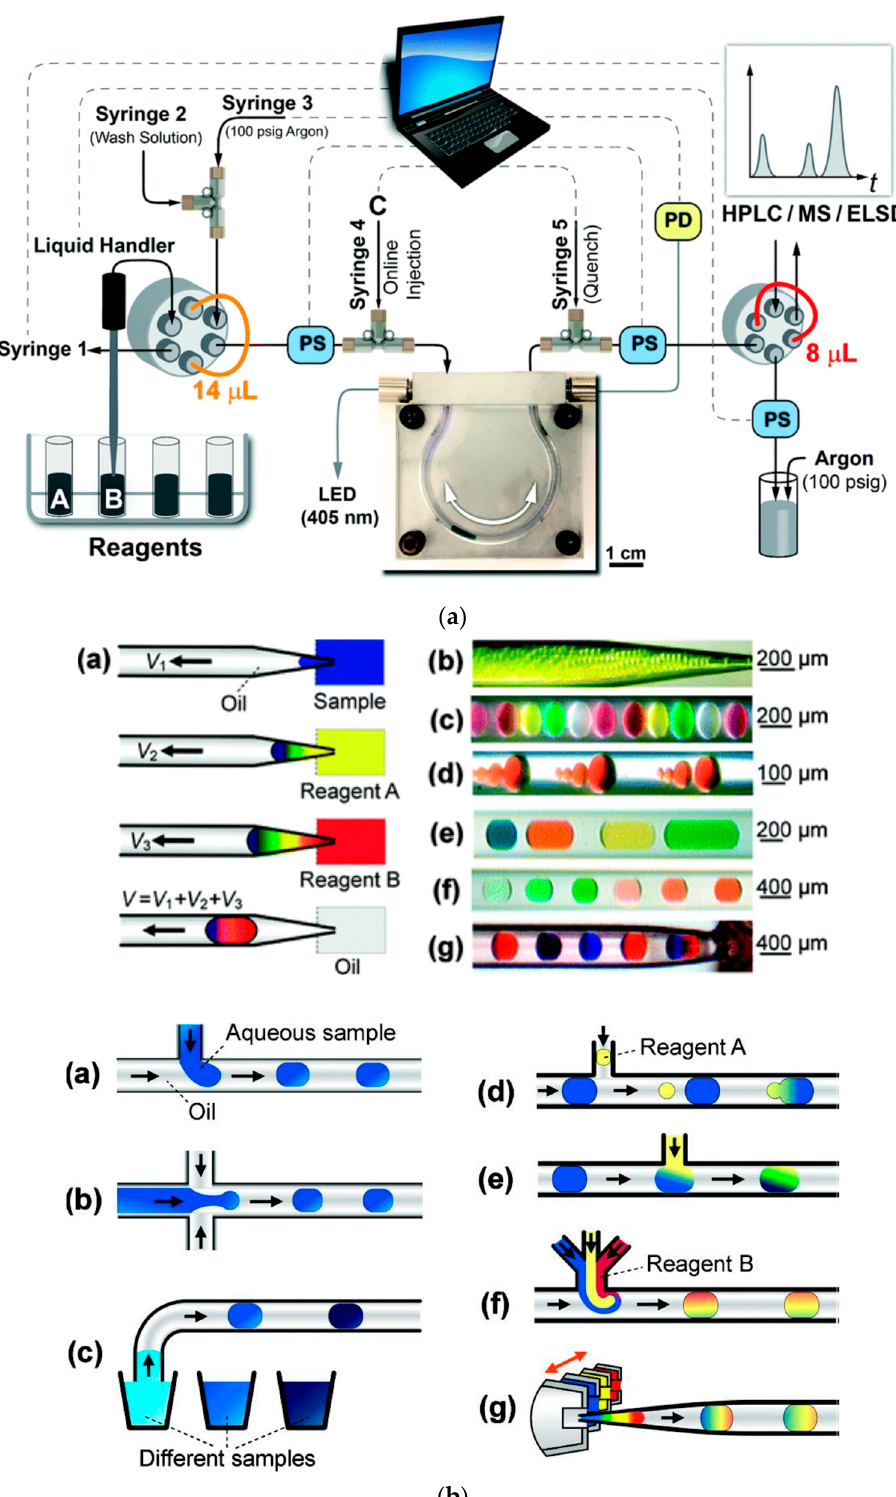
Figure 6. Examples of droplet-based flow systems developed for synthetic ( a ) [269] and analytical ( b ) [270] purposes: ( a ) schematic of the automated droplet-based medicinal chemistry platform [269]. PS—phase sensor; PD—photodetector. Dashed lines indicate personal computer (PC) commu- nication, gray lines correspond to the optical fibers for the light-emitting diode (LED) and the photodetector, and solid black lines correspond to the fluoropolymer tubing for the delivery and routing of liquid droplets; ( b ) principle and performance of DropLab [270]. (a) Schematic diagram of principle for assembling a three-component droplet using DropLab; (b) continuous generation of